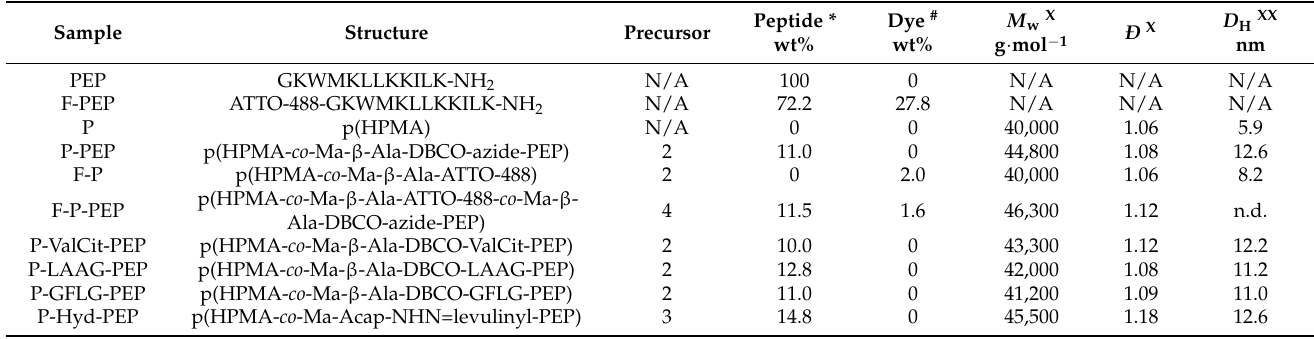
Table 2. Characterization of the peptide derivatives and polymer-peptide